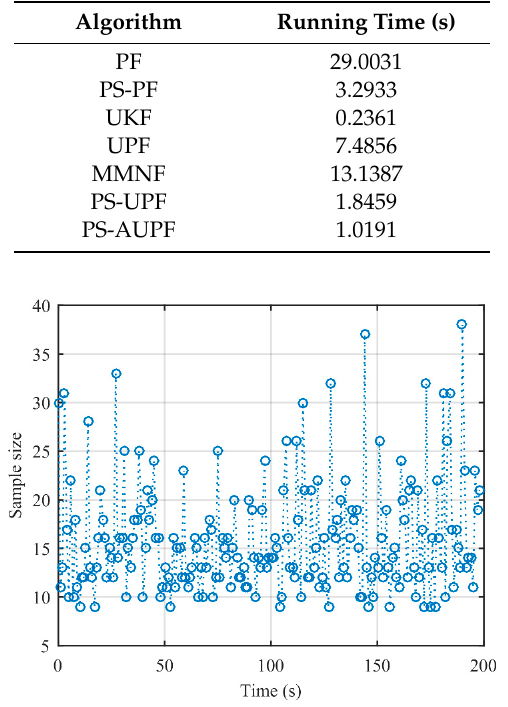
Figure 9. Changes of sample size in adaptive sample-size unscented particle filter with partitioned sampling (PS-AUPF) during a tracking process.